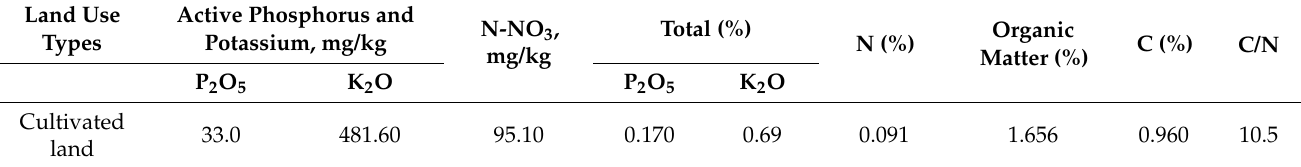
Table 8. The agrochemical properties of irrigated soil in the Kibray district.